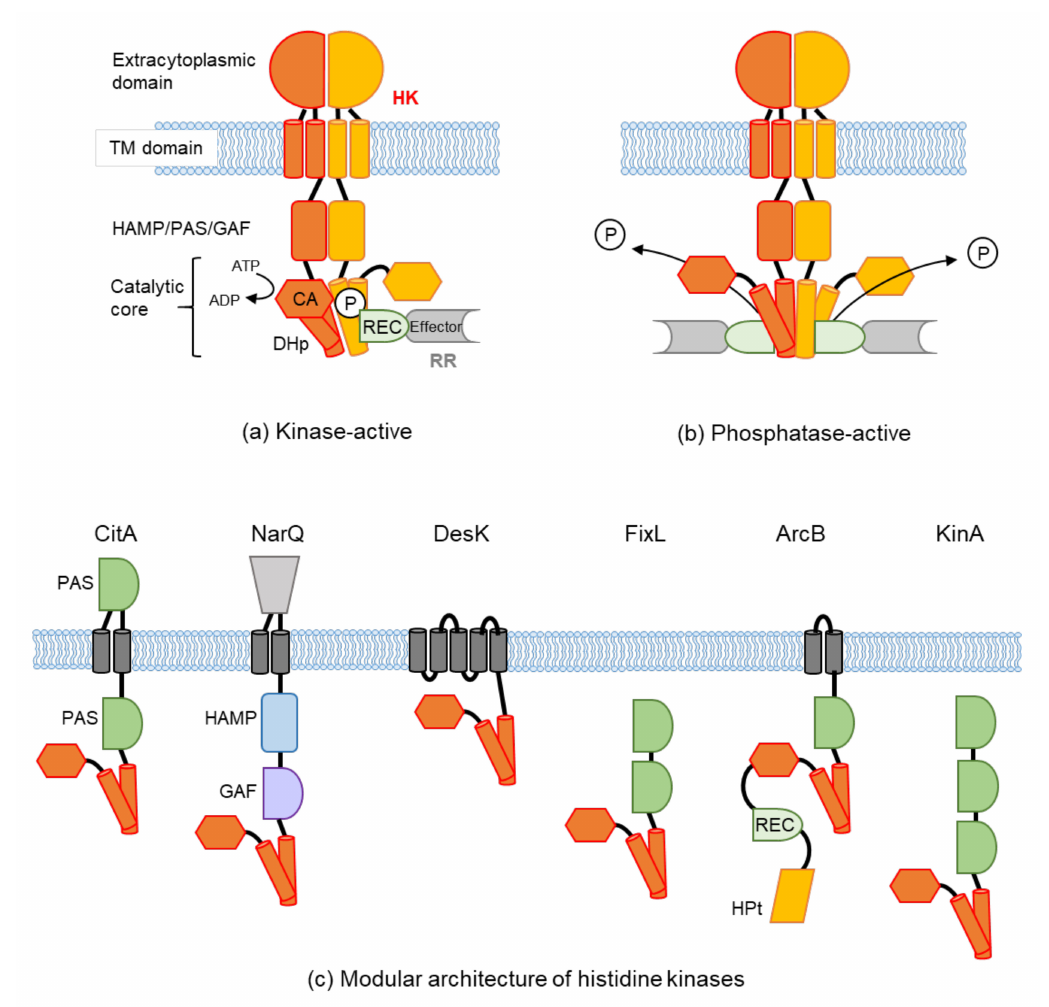
Figure 1. Schematic representation of a prototypical sensor histidine kinase (HK) and its variants. ( a ) In a prototypical HK, a kinase-activating signal perceived by the extracytoplasmic domain is transduced across the membrane via the transmembrane (TM) domain, transmitted through the intracellular signal domains (HAMP, a domain found in histidine kinases, adenylyl cyclases, methyl binding proteins, and phosphatases; PAS, Per-ARNT-Sim; or GAF, a domain found in cGMP-specific phosphodiesterase, adenylyl cyclases, and FhlA), and eventually to the catalytic core, consisting of DHp (dimerization and histidine phosphorylation) and CA (catalytic/ATP binding) domains. The catalytic core adopts an asymmetric kinase-active conformation with ATP binding to the CA domain and autophosphorylating the conserved His residue in the DHp domain. The phosphate moiety (P) is then transferred to the Asp residue in the receiver (REC) domain of its partner response regulator (RR). The phosphorylated RR triggers downstream responses through its effector domain. ( b ) When the extracytoplasmic domain perceives a repressive signal, this signal is also transduced to the catalytic core. The catalytic core changes into a symmetric phosphatase-active conformation. The phosphorylated RRs are dephosphorylated, which turns off the system. ( c ) Variation in the modular architecture of various HKs. HKs normally exist as dimers but are shown as monomers for simplification. HKs can either reside in the membrane or in the cytoplasm without TM helices. Numbers and locations of signal domains such as HAMP, PAS, or GAF vary among HKs. In hybrid HKs such as ArcB, the receiver (REC) and histidine phosphotransfer (HPt) domains are fused to the C-terminal end of the CA domain. The phosphate moiety is relayed from the DHp domain to the REC and HPt domains before being transferred to the